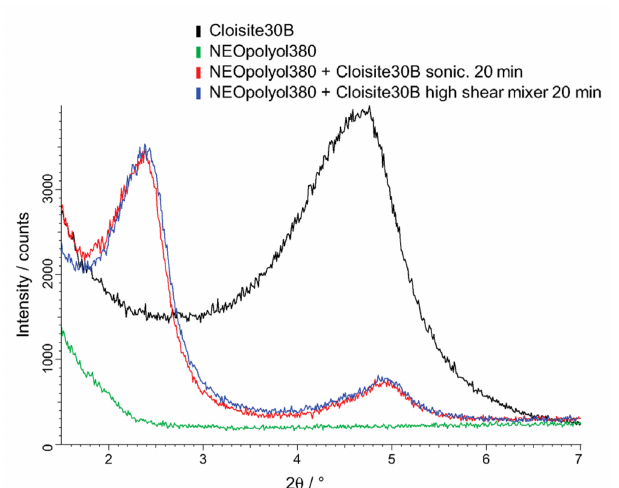
Figure 16. XRD-patterns of ( black ) Cloisite-30B, ( green ) NEOpolyol-380, or a 5% dispersion of Cloisite-30B in NEOpolyol-380 made by ( red ) sonication for 20 min or ( blue ) high shear mixing for 20